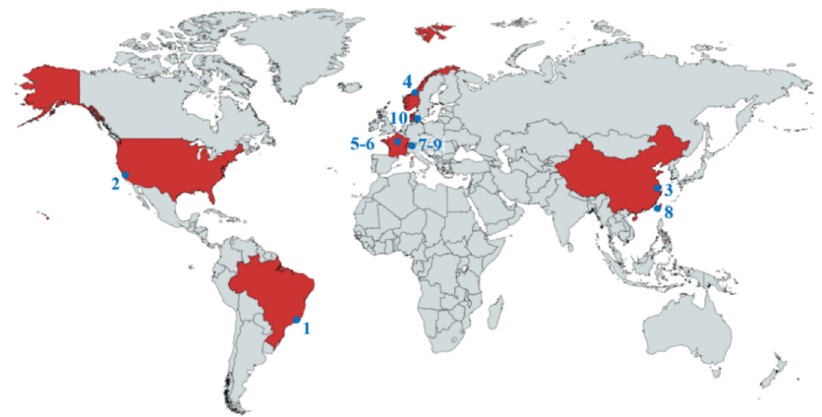
Figure 1. Geographical distribution of the examined case studies.